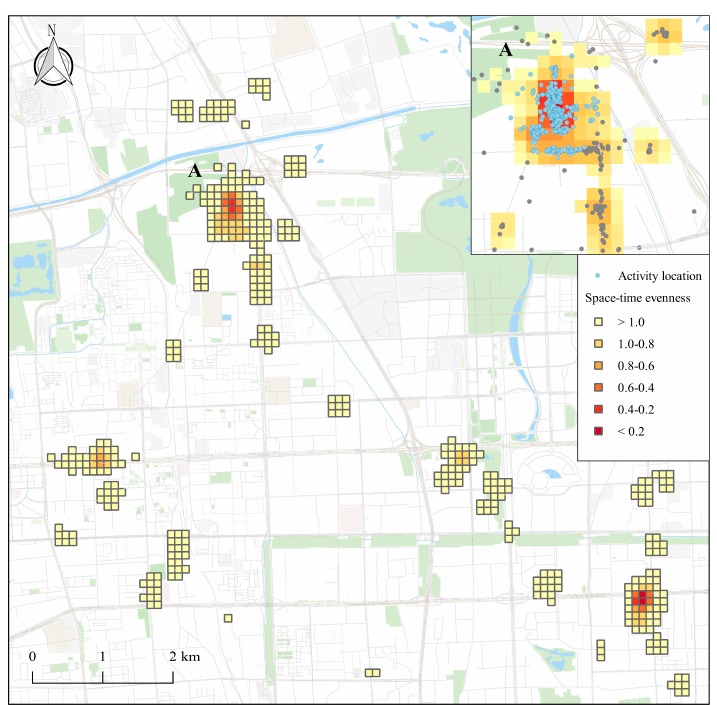
Figure 5. An example of space-time evenness grids. The dark color suggests uniform activity distribution across time and light color means intermittent occurrence of activities. Cluster A is a candidate of significant places.